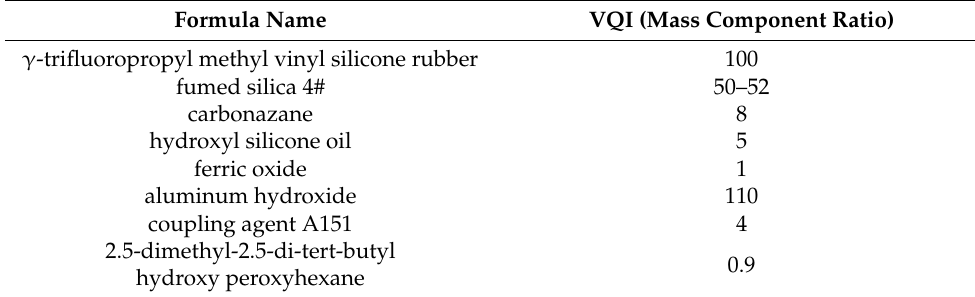
Table 2. Formula composition of test fluorosilicone silicone rubber materials.